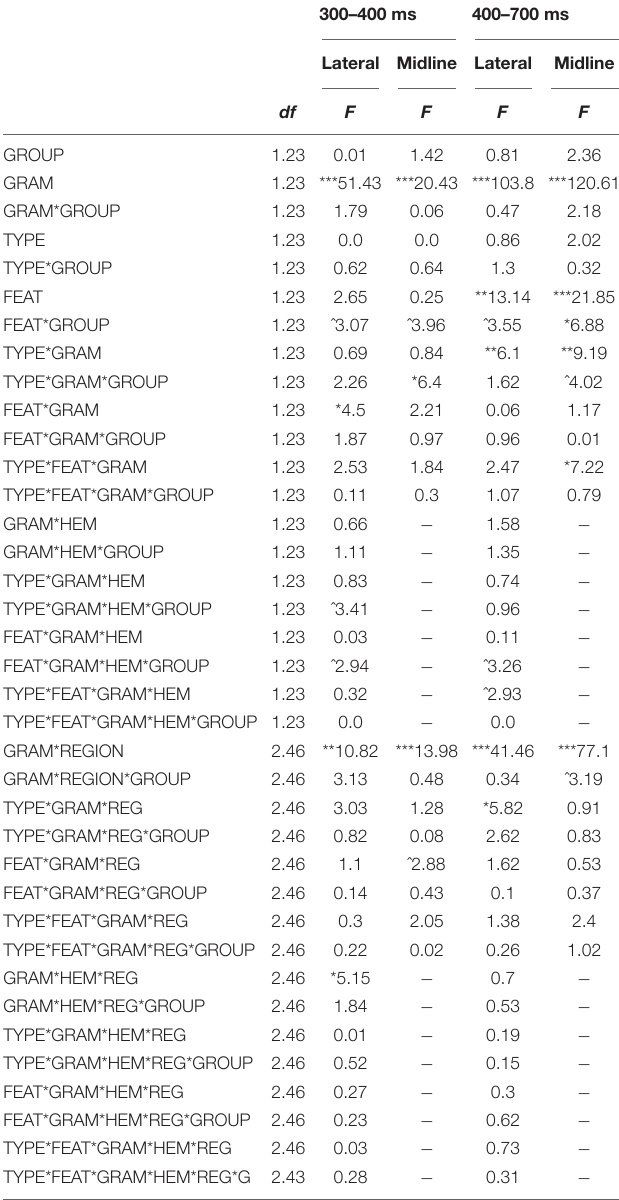
TABLE 4 | Summary of the ERP results.